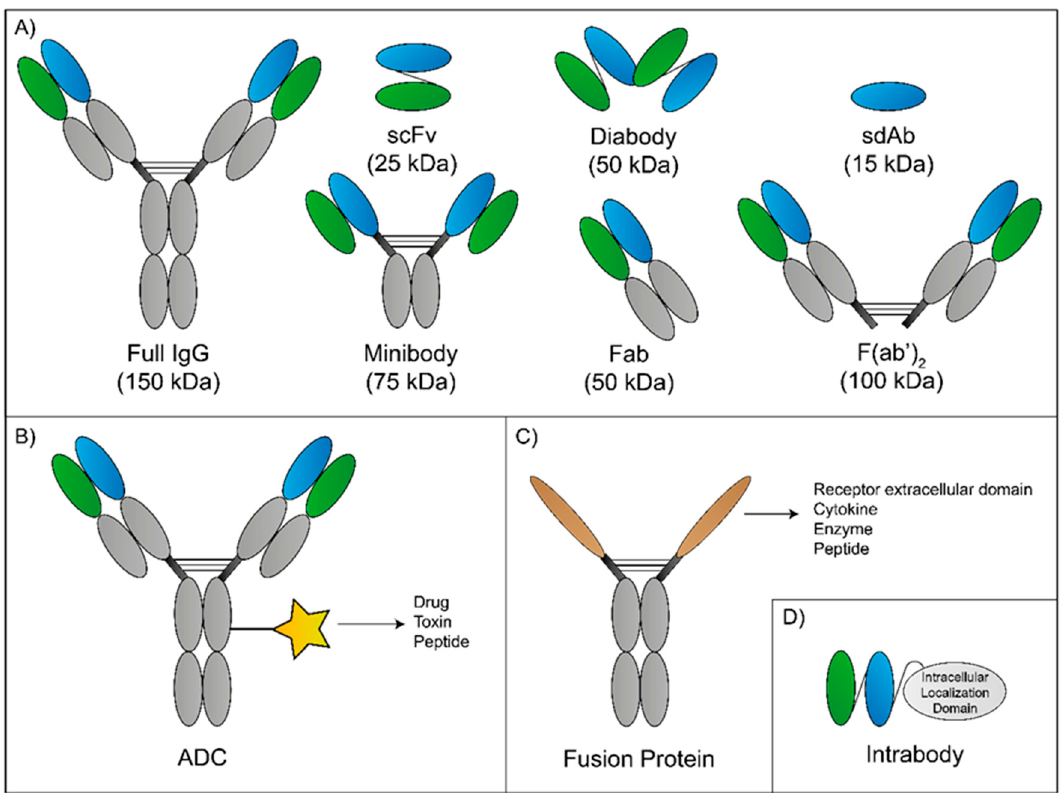
Figure 4. Novel or innovative monoclonal antibody (mAb) strategies. Schematic representation of di ff erent antibody formats currently in research. ( A ) An intact IgG molecule alongside with various antibody fragments and their respective molecular weight. ( B ) Antibody-drug conjugates (ADC) are usually intact IgG molecules linked to a drug, toxin, or peptide to increase the cargo selectivity. ( C ) Fusion proteins are biopharmaceutical molecules where the binding domains can be derived from a receptor extracellular domain, cytokine, enzyme, and peptide. Depending on the IgG molecule, the Fc region is capable of Fc γ R and C1q binding, potentially enabling the fusion protein to initiate antibody-dependent cell-mediated cytotoxicity (ADCC) and complement-dependent cytotoxicity (CDC). ( D ) The scheme shows an intrabody made of a variable region of the light and heavy chain constituting the antigen-binding domain and an intracellular location domain to allow nuclear binding.